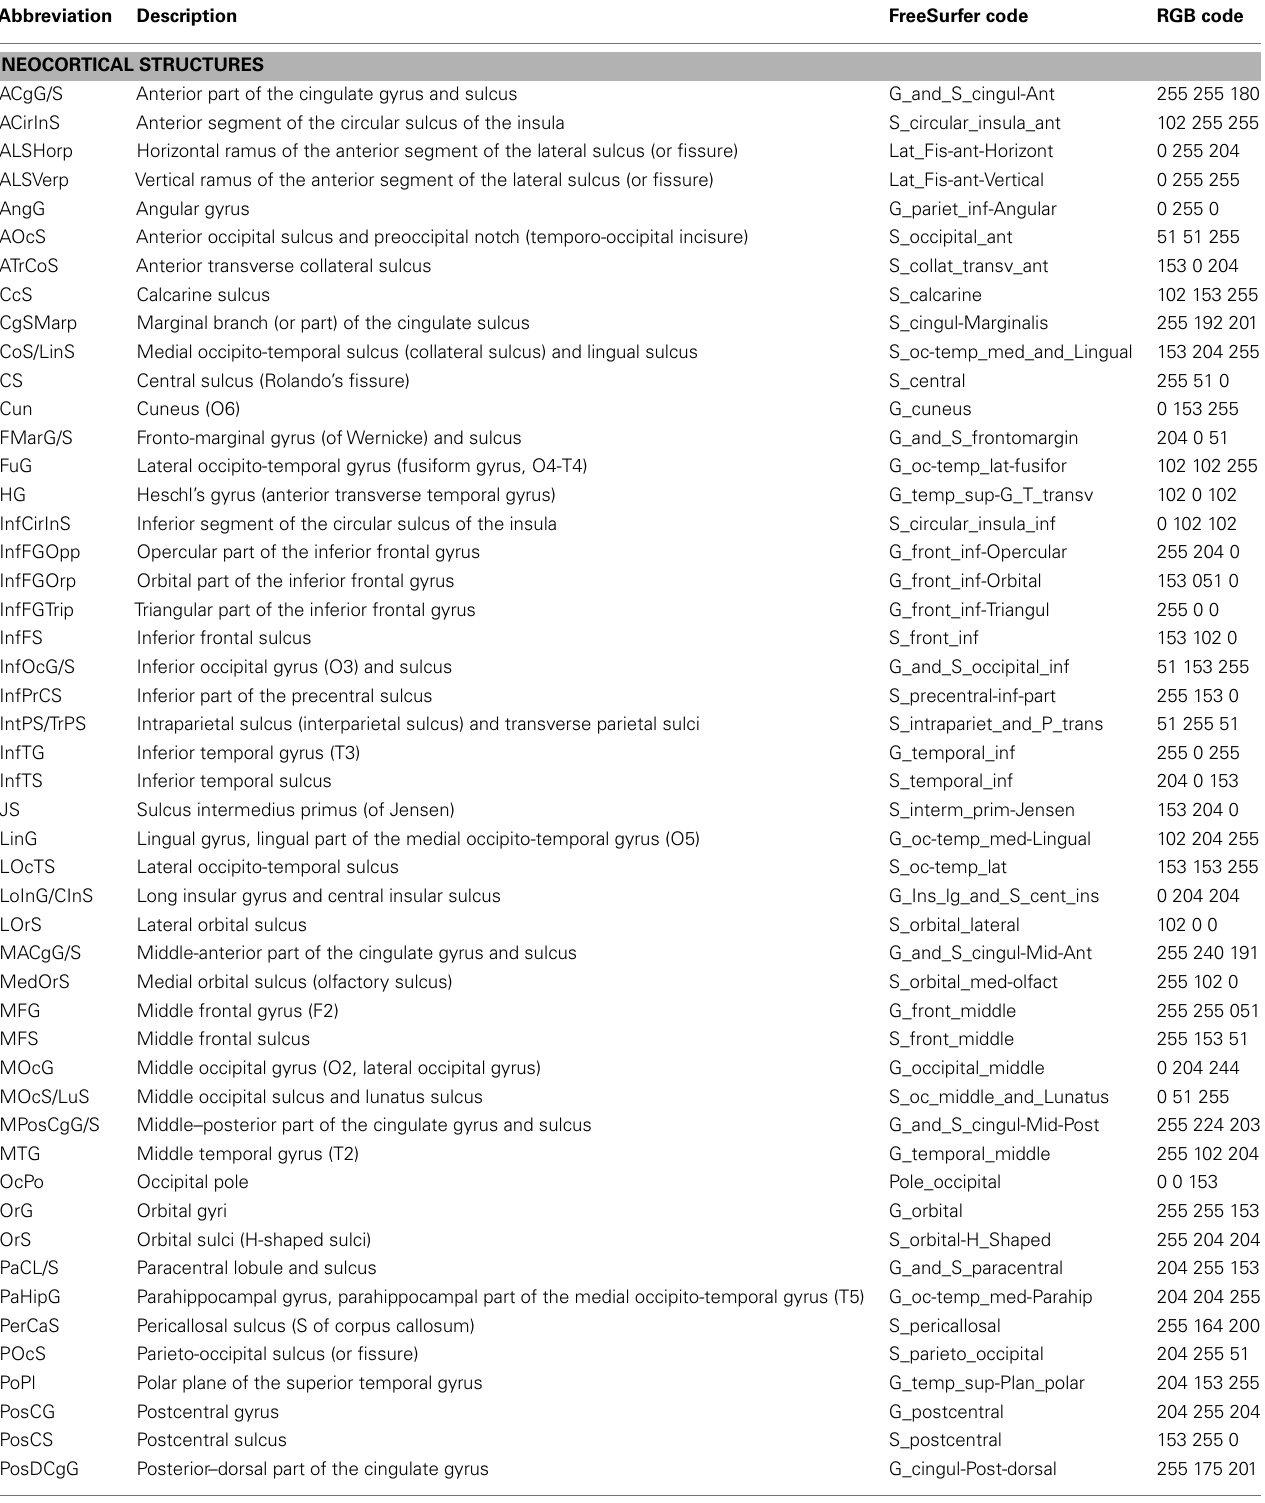
TableA1 | Summary of each parcelation’s abbreviation, full description, and FreeSurfer code as defined in the original parcelation scheme (Destrieux et al., 2010), as well as the associated RGB code in the